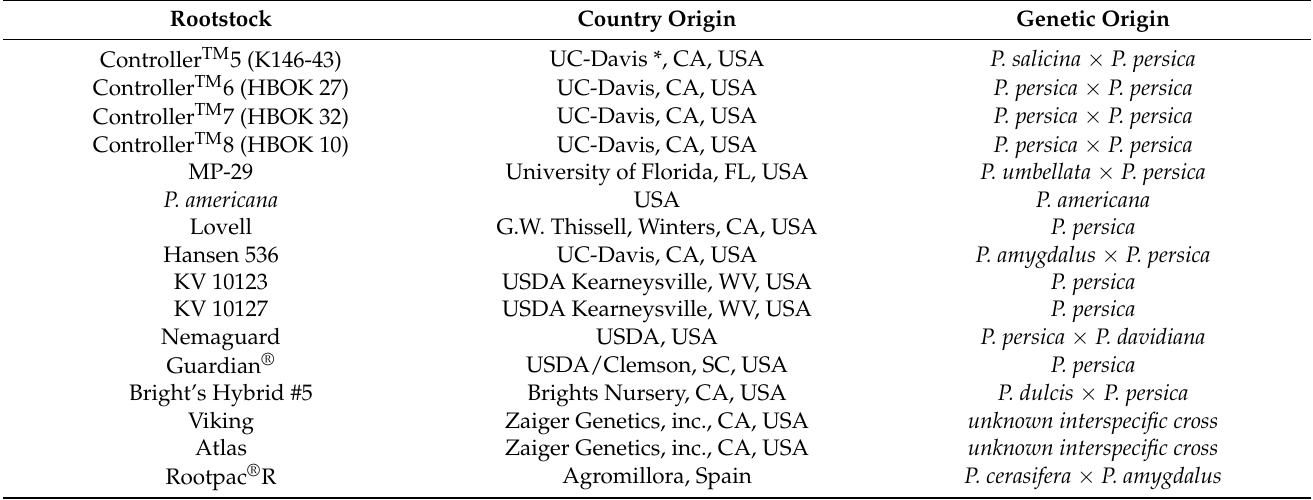
Table 1. Peach rootstock genotypes and breeding programs around the world.